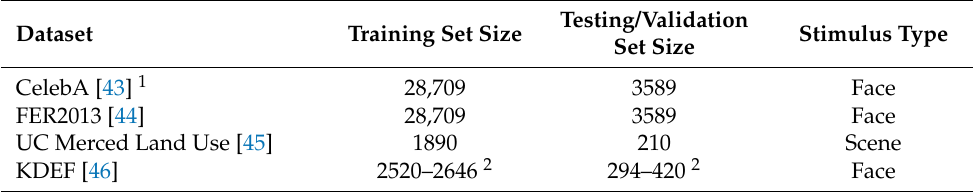
Figure 1. Face image examples. Top: naturalistic face images, similar to those from the CelebA and FER2013 datasets. Bottom: selected images from KDEF dataset (AF01AFHR, AF02SUHL, AF05AFS, AM01ANS, AM10HAHL, AM27NEHR). Table 1. Dataset